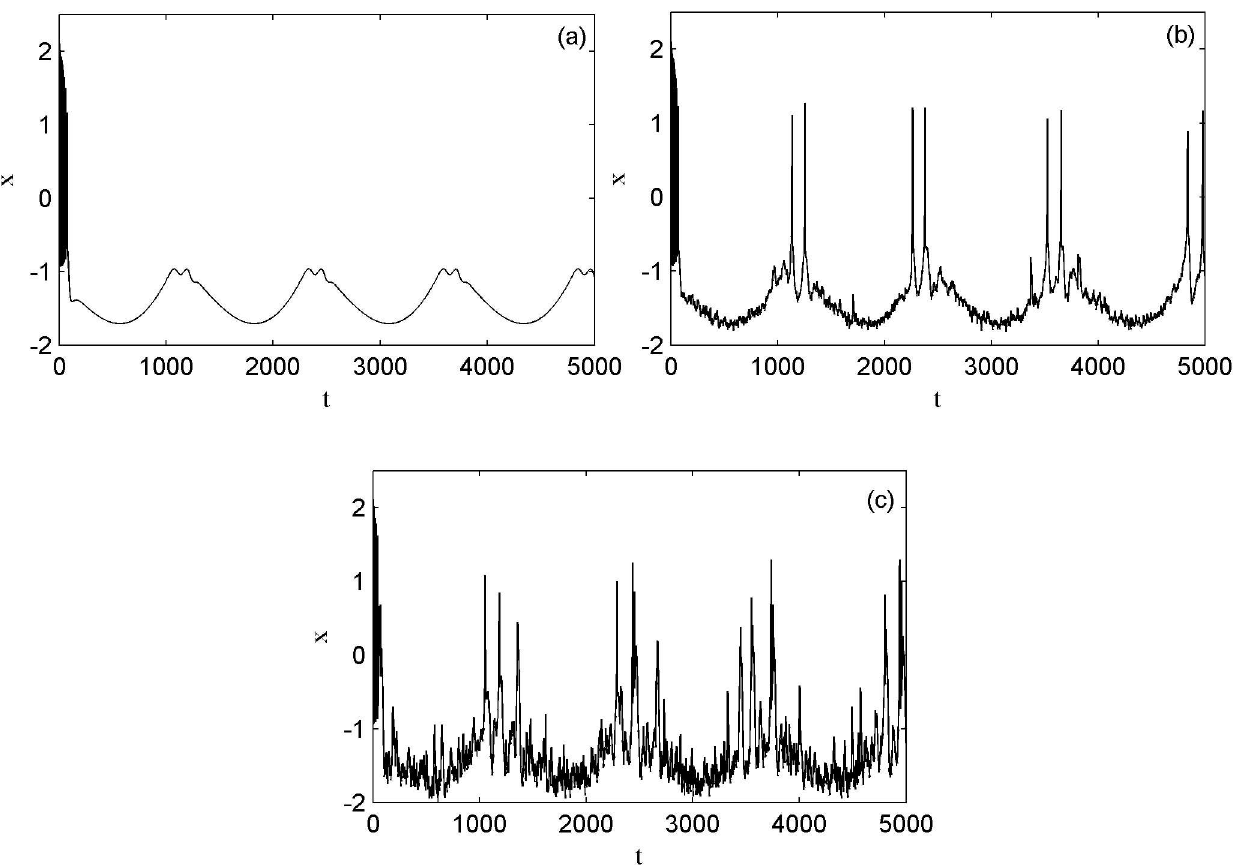
Fig 2. The time series of the membranepotential of neuron under different external radiation-induced magnet flux.